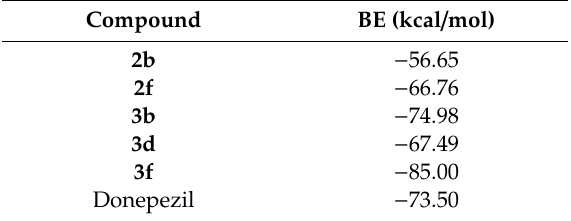
Figure 3. Docking poses of donepezil (yellow), 2b (orange) and 3f (purple) represented with AChE (1GQR) in ribbon format ( a ). The 2-dimensional (2D) plots of docking results for 2b ( b ), 2f ( c ), 3b ( d ) 3d ( e ) and 3f ( f ) into AChE including bonding interaction distances. Bright green represents conventional hydrogen bonds, light green—van der Waals interactions, very light green carbon hydrogen bonds, dark pink—pi–pi interactions, light pink—pi–alkyl interactions, blue—halogen (florine) interactions and orange—pi–cation interactions. Table 7. Calculated binding free energy (BE) values 2b , 2f , 3b , 3d and 3f .